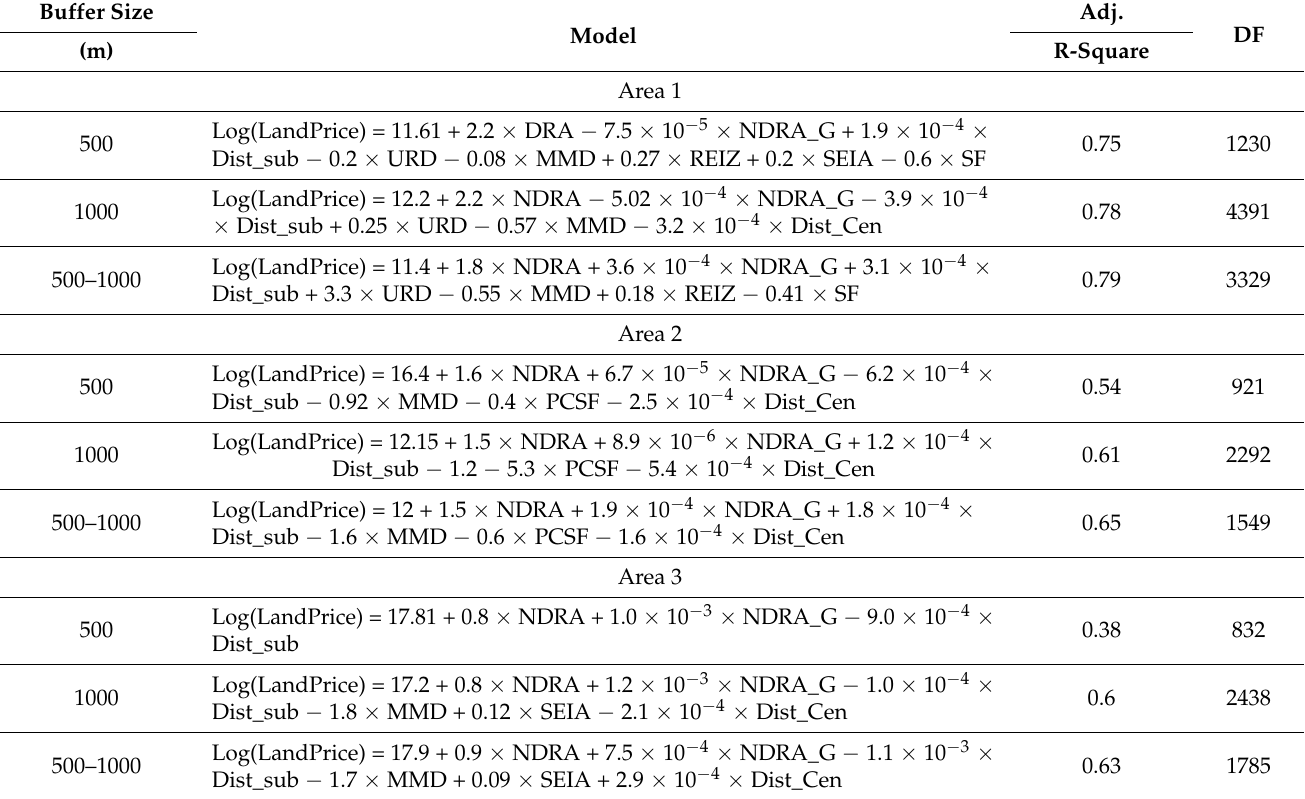
Table 2. Regression models for each